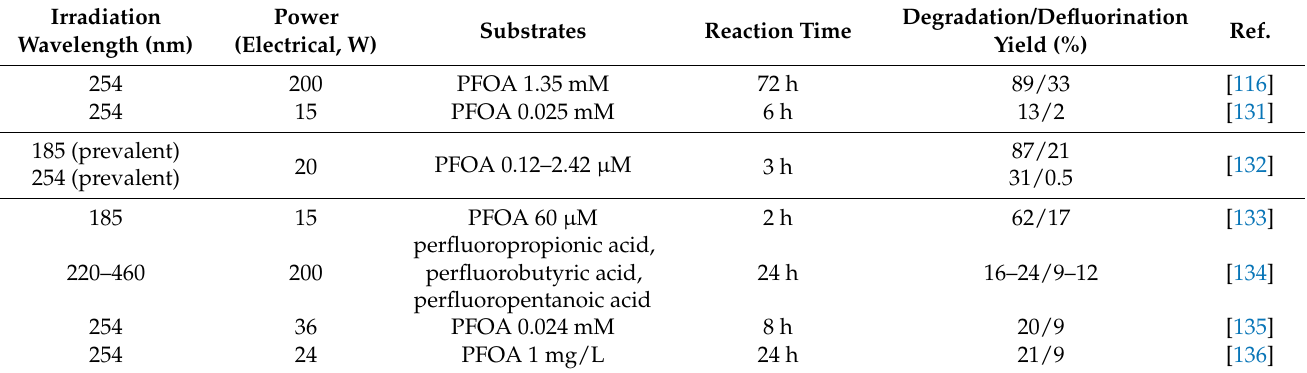
Table 2. Direct photolysis of PFAS compounds in